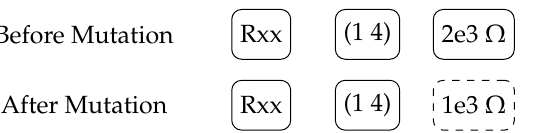
Figure 3. A minor circuit mutation where only the value of the element changes (dashed).